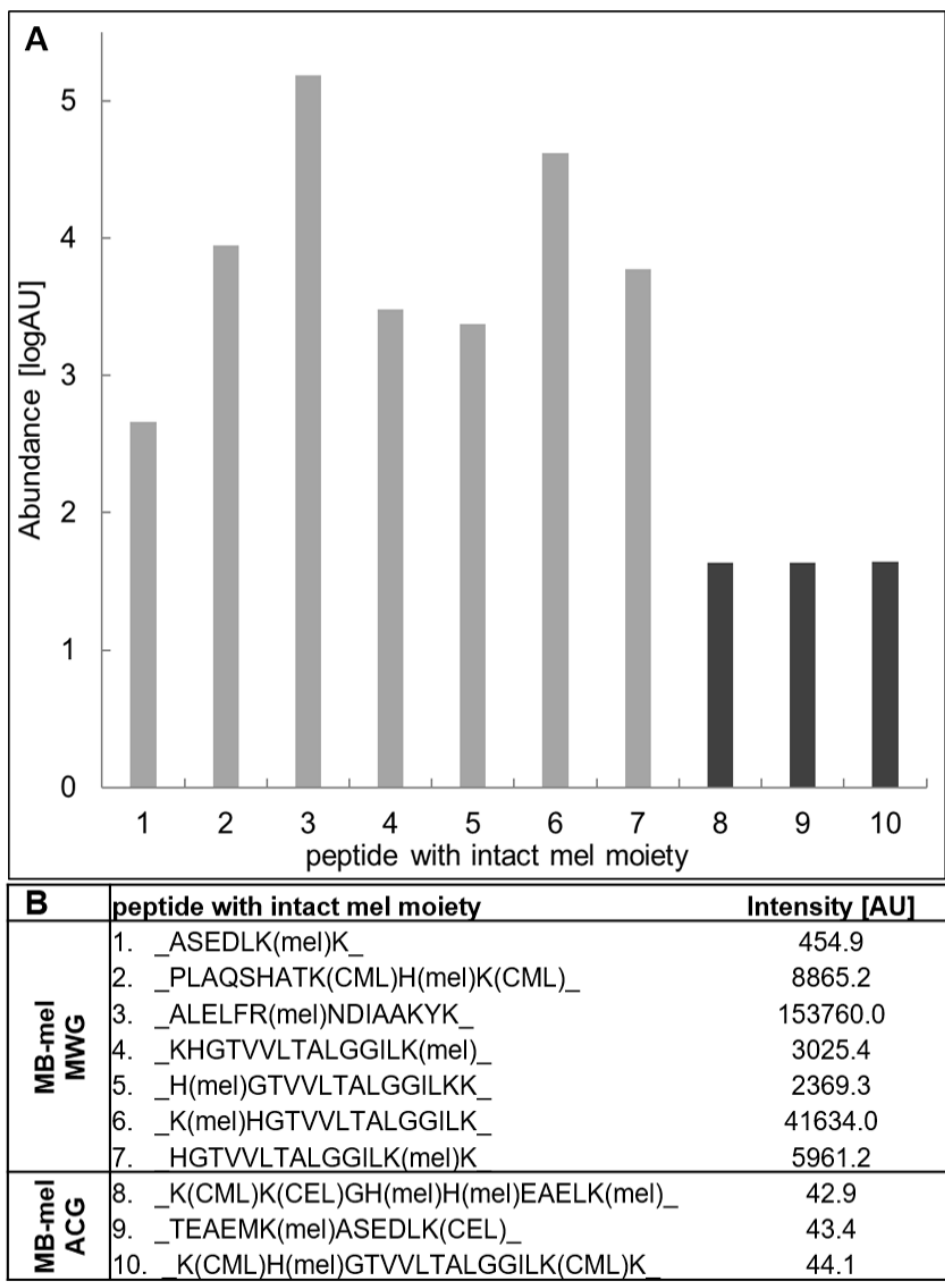
Figure 6. The abundance of the peptides modified with the intact mel moieties was identified on the glycated MB. Comparison of the abundance expressed as the log of MS signal intensities measured in arbitrary units (AU) recorded for peptides with the intact mel modification found in MB-mel MWG (light grey bars, peptides 1 – 7) and MB-mel ACG (dark grey bars, peptides 8 – 10) ( A ). The sequences of individual peptides (1 – 10) carrying the mel-modifications and their MS intensities are shown in table ( B ).